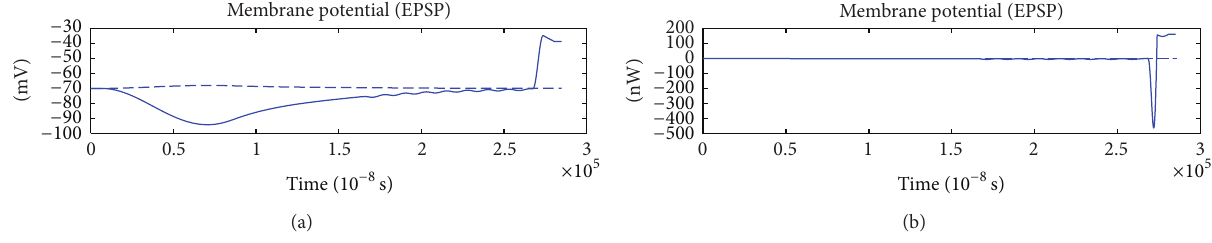
Figure 11: The EPSP and the corresponding energy function. 𝑟 0𝑚 = 0.0001 Ω , 𝑟 1𝑚 = 0.1 Ω , 𝑟 2𝑚 = 1000 Ω , 𝑟 3𝑚 = 0.1 Ω , 𝑟 𝑚 = 1000 Ω , = 1 𝜇 F, 𝐿 = 50 𝜇 H, 𝑖 = 7.155 𝜇 A, and 𝑄 = 1 × 10 −4 𝜇 A. 𝐶 𝑚 𝑚 0𝑚